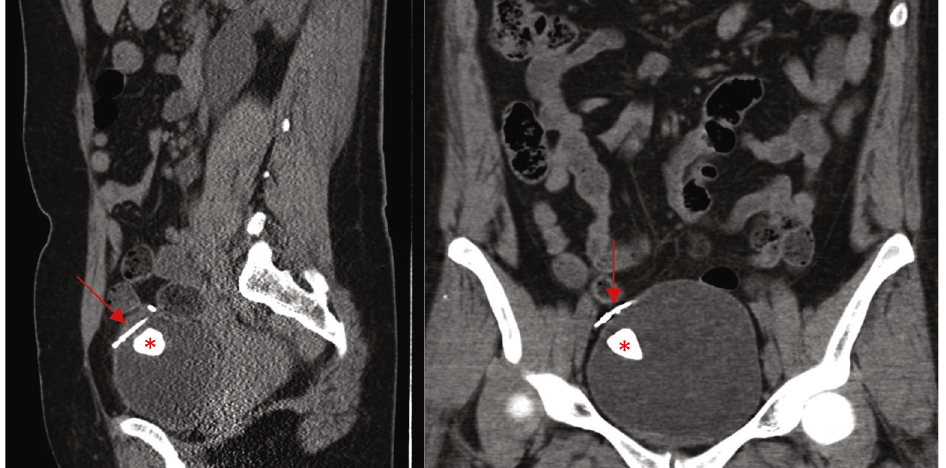
Figure 1: Sagittal and coronal noncontrast CT images showing large bladder calculus (red asterisk) and portion of partially intravesical T- shaped foreign body lodged in right anterior bladder wall (red